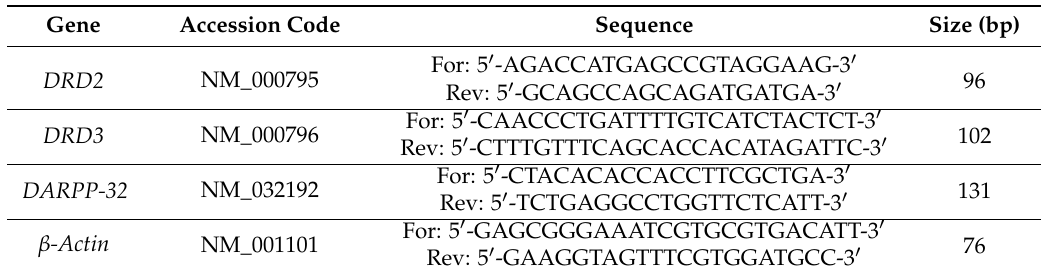
Table 5. The primer sequences of DRD2 , DRD3 , DARPP-32 , and β -Actin